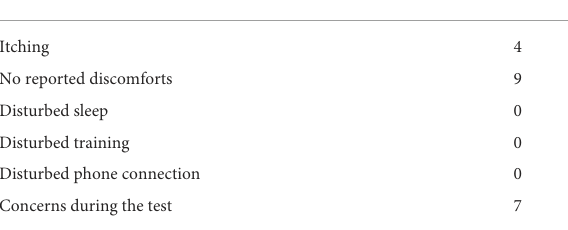
TABLE 1 Usability of ECG247 smart heart sensor.